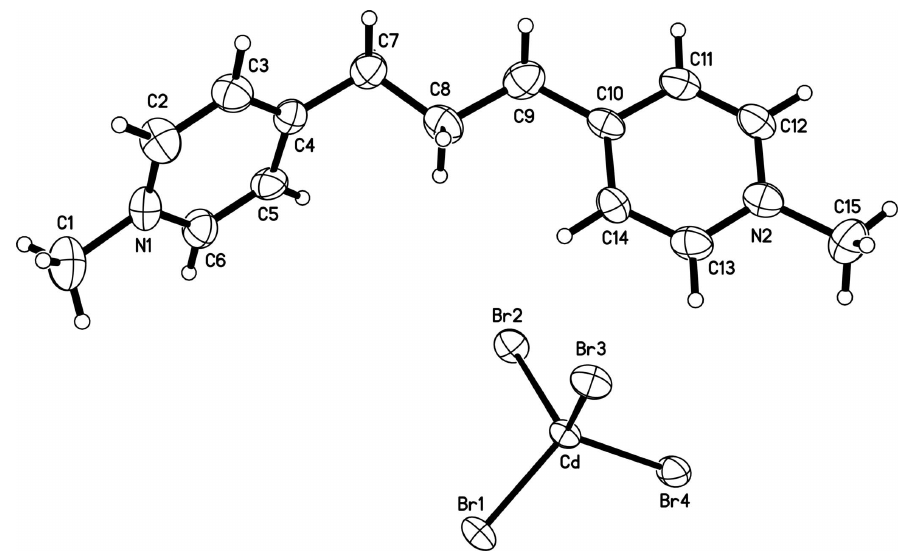
Figure 1 The molecular structure of (I), with the atom-labeling scheme and 30% probability displacement ellipsoids.